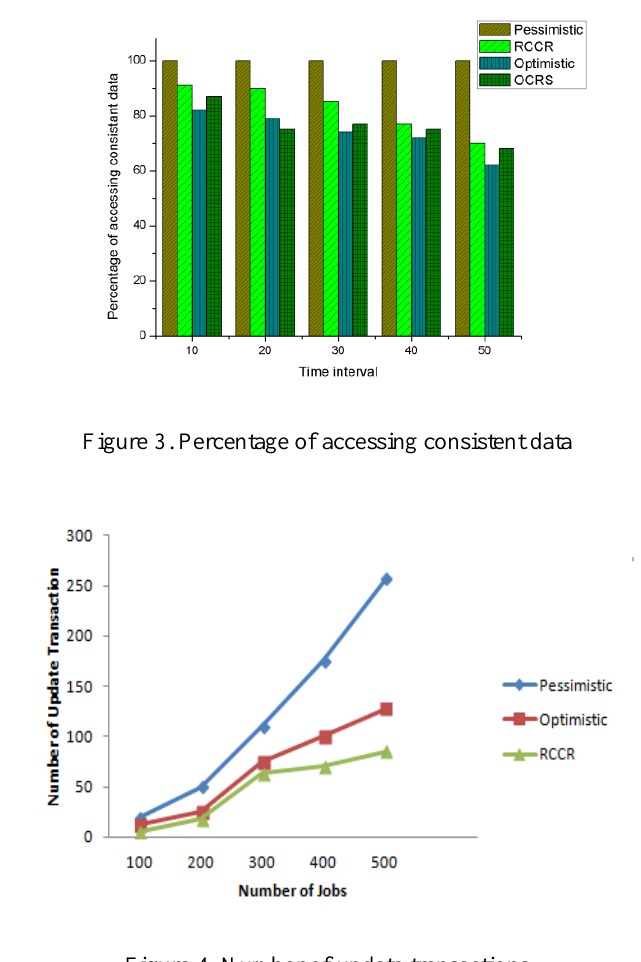
Figure 4. Number of update transactions